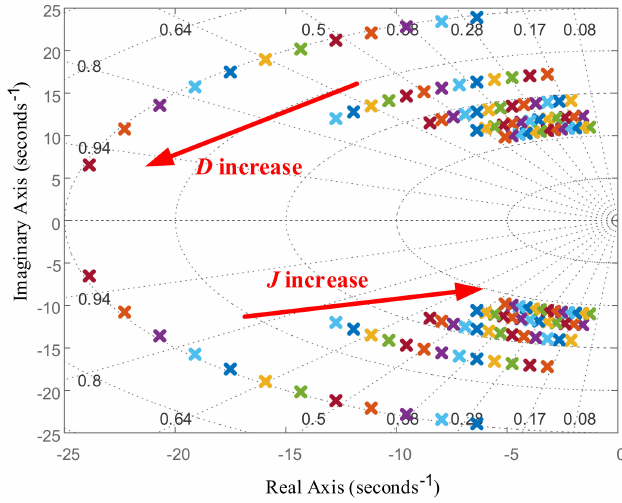
Figure 5. The changing trend of poles in GC